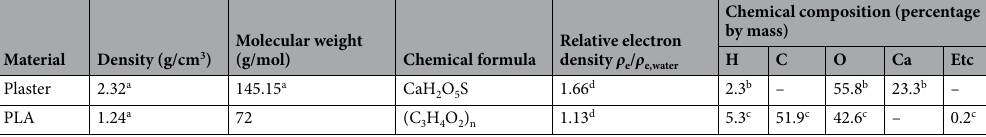
Table 1. Physical properties of plaster and PLA. a Provided by each fabricator. b Ref 14 . c Ref 15 . d Measured by CT.